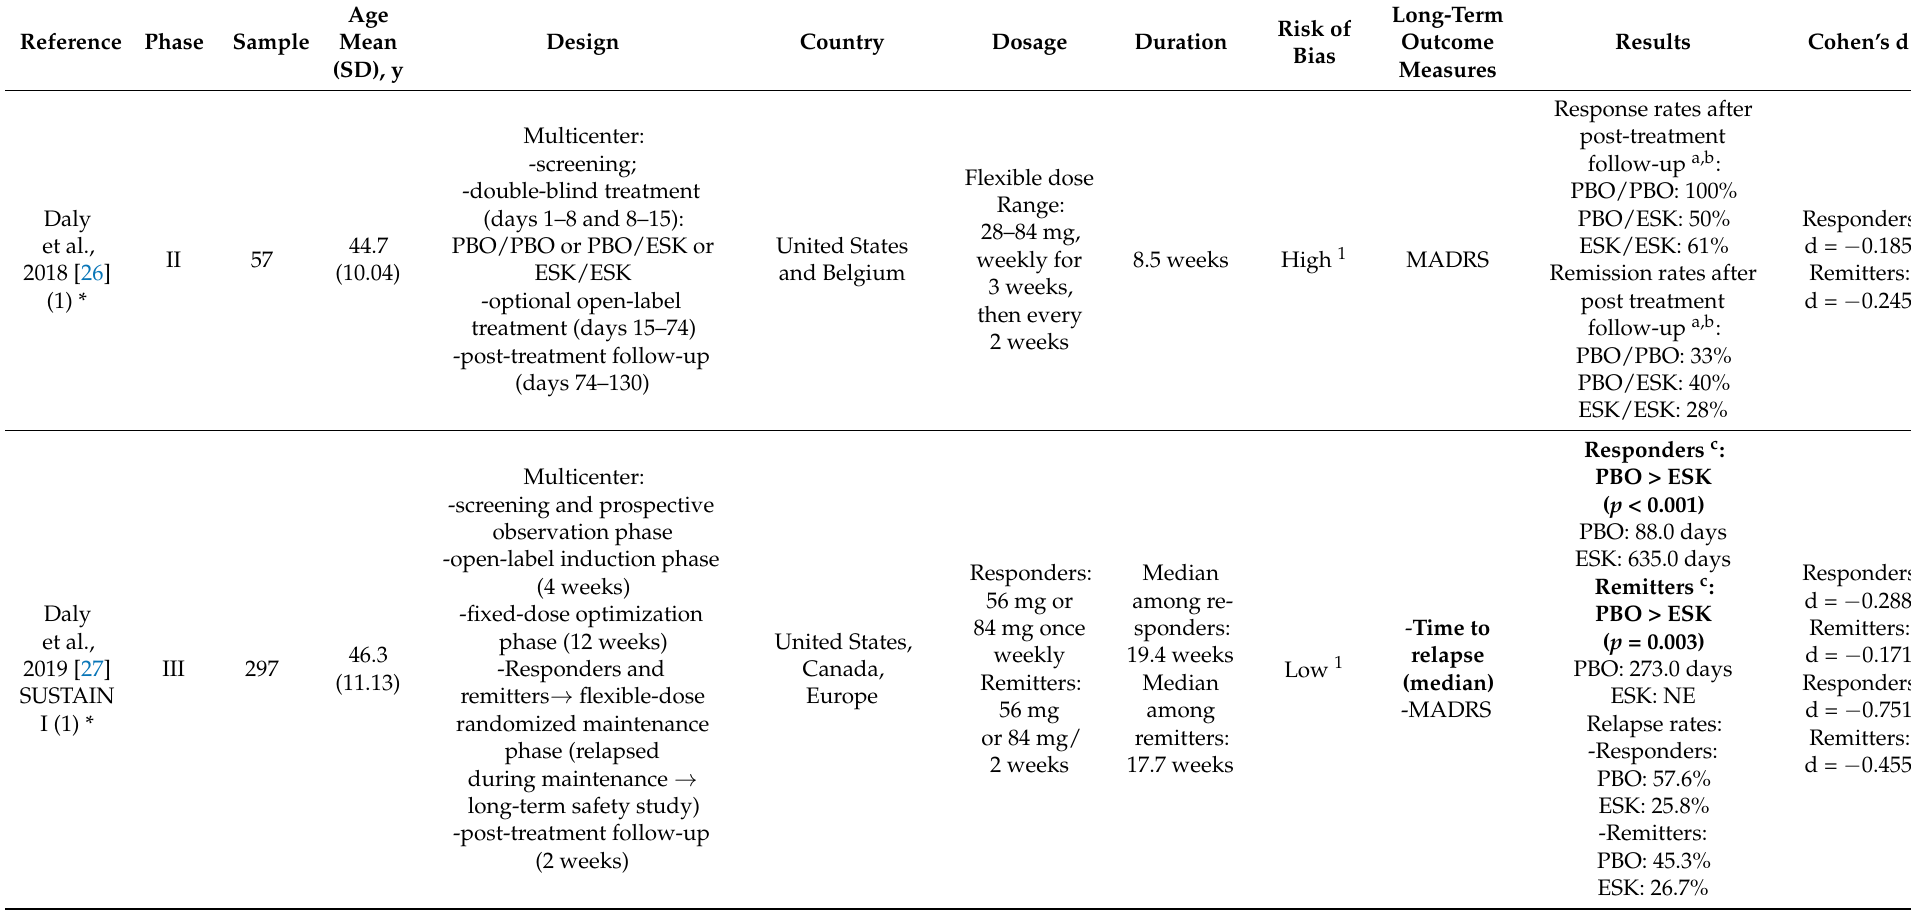
Table 1. Summary of the studies on intranasal ESK efficacy in the continuation-treatment phase with ESK after the 4-week induction phase.